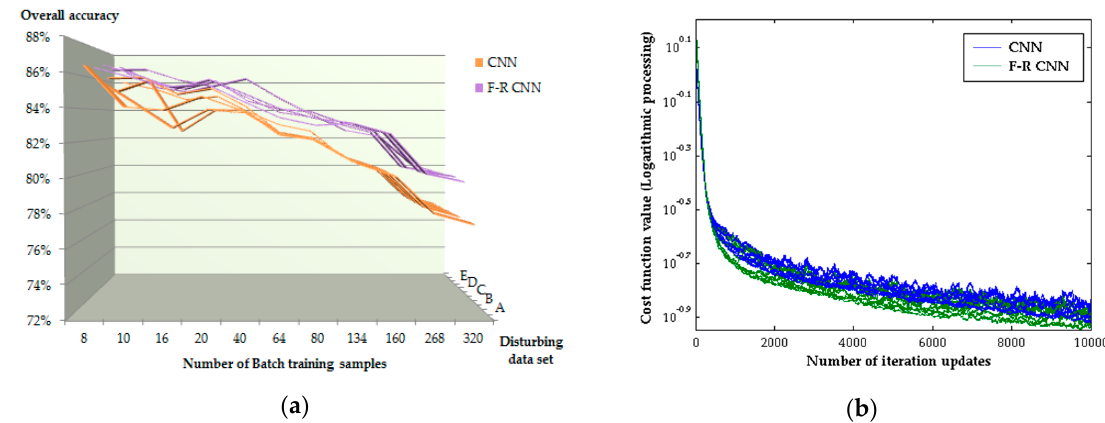
Figure 13. Test accuracy curve and cost function convergence curve. ( a ) Test accuracy evaluation of different batch training numbers in two models. Data A, B, C, D and E represent 20 times the training samples of different disturbance levels; ( b ) cost function convergence curves.